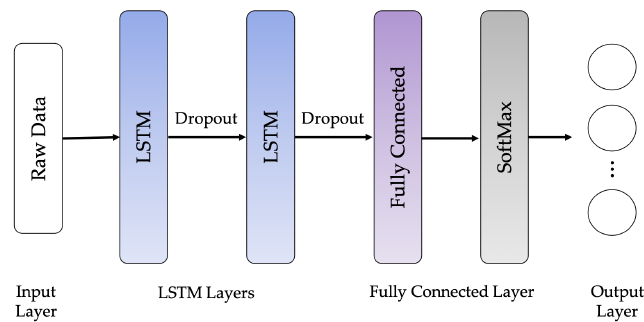
Figure 11. 2-Stacked LSTM network architecture.